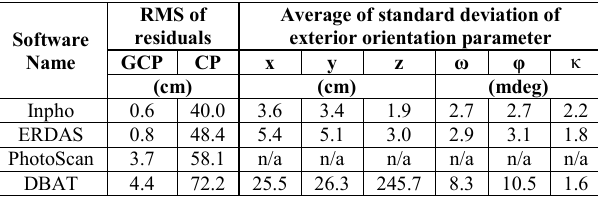
Table 2. Comparison of the bundle adjustment